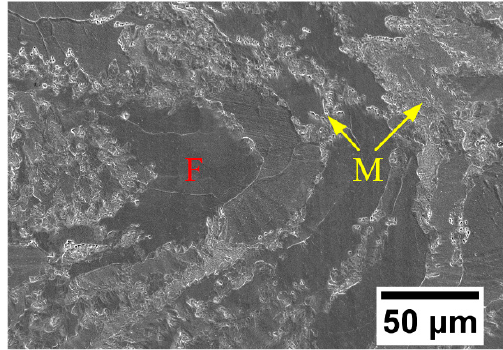
Materials 2019 , 12 , x FOR PEER REVIEW Figure 4. SEM micrograph of the deposited 410L alloy. Figure 4. SEM micrograph of the deposited 410L alloy.